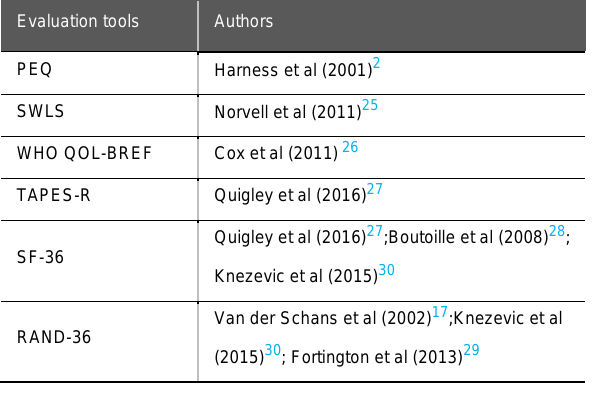
Table 4: Overview of the tools used for HS and